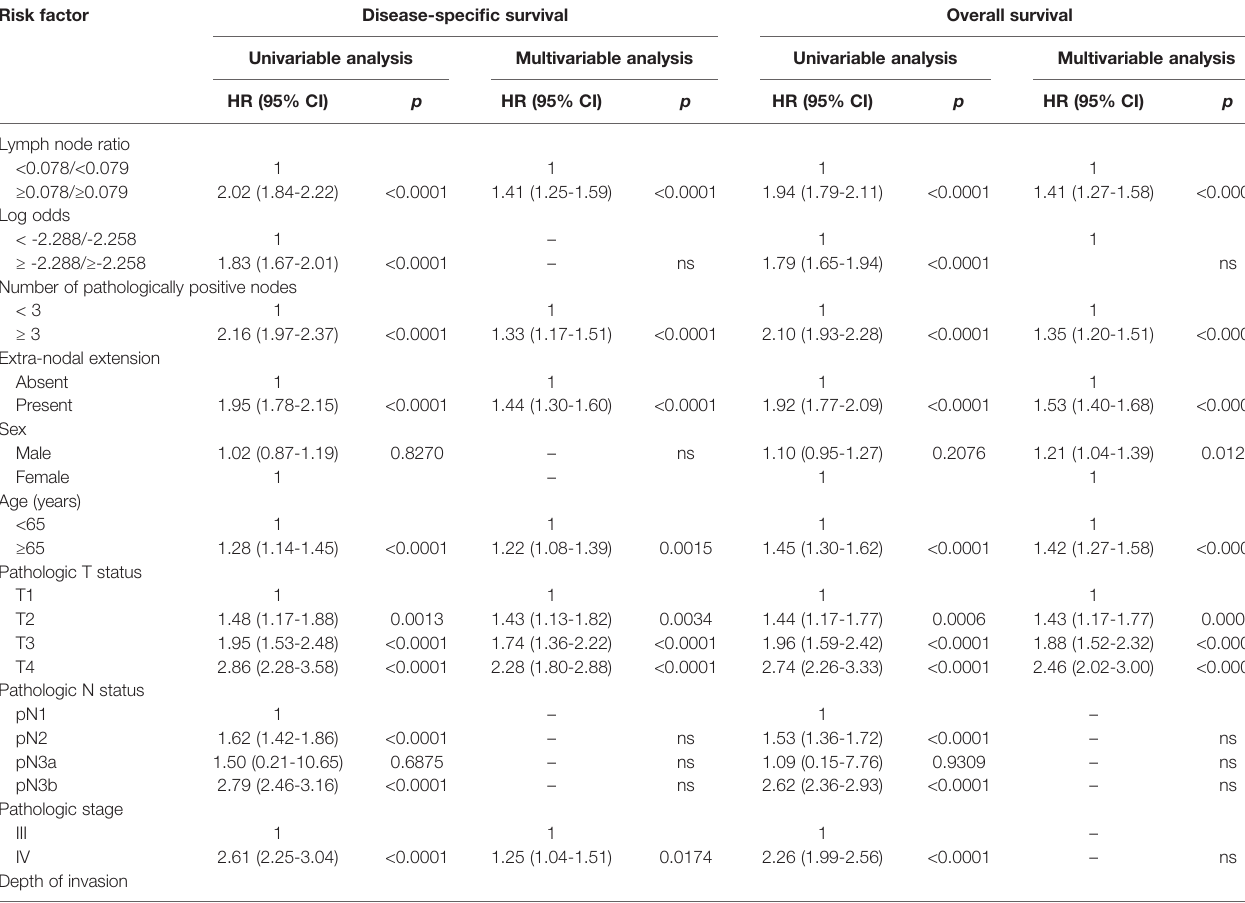
TABLE 2 | Univariable and multivariable analyses of risk factors for 5-year disease-speci fi c survival and overall survival in the entire study cohort (n = 4287). Risk factor Disease-speci fi c survival Overall survival Univariable analysis Multivariable analysis Univariable analysis Multivariable